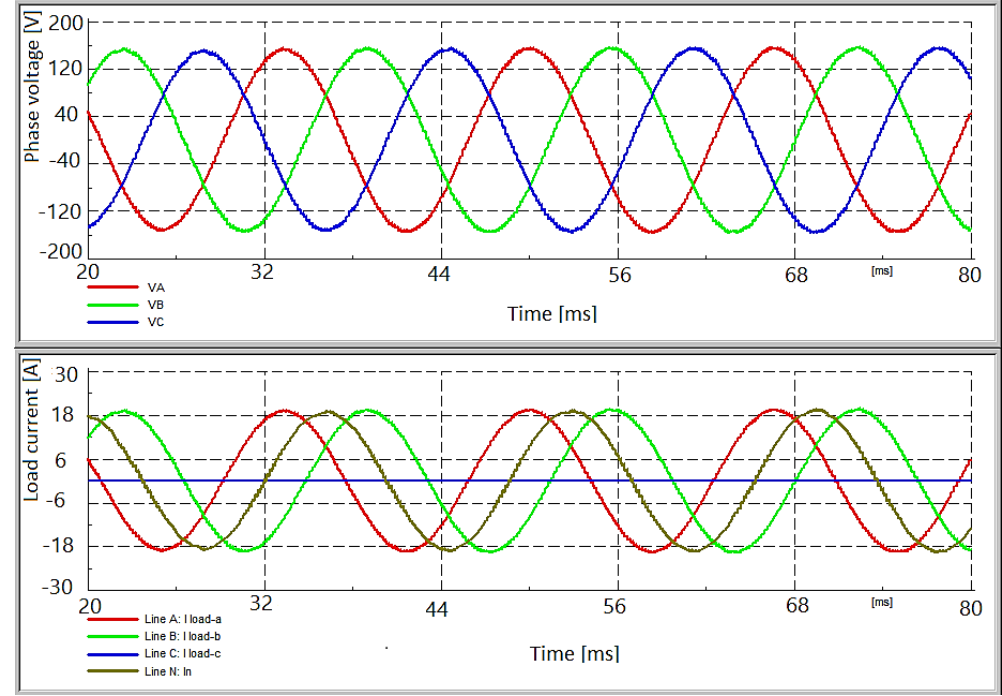
Figure 16. Output three-phase voltages and currents for Unb.#2.